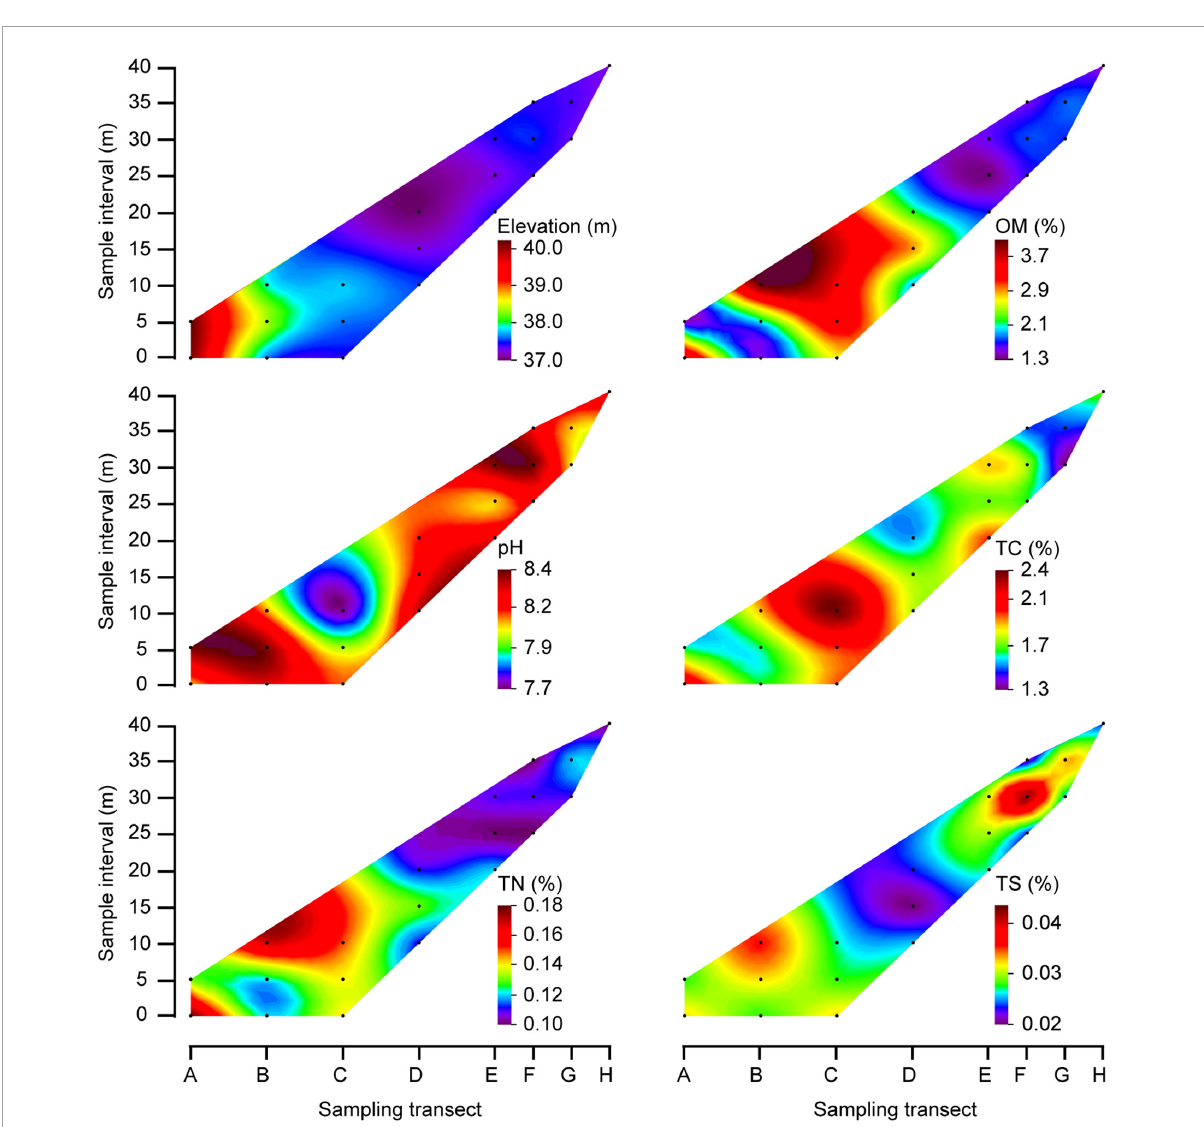
FIGURE2 Contour plots showed physico-chemical properties of bulk soils in the MCB. The black dots indicate the sampling quadrats, which correspond to the quadrat orders depicted in Figure 1 . The color fill plot represents a 3-dimensional bulk by plotting contours on a 2-dimensional format using Origin soft. Capital letters: longitudinal position of the